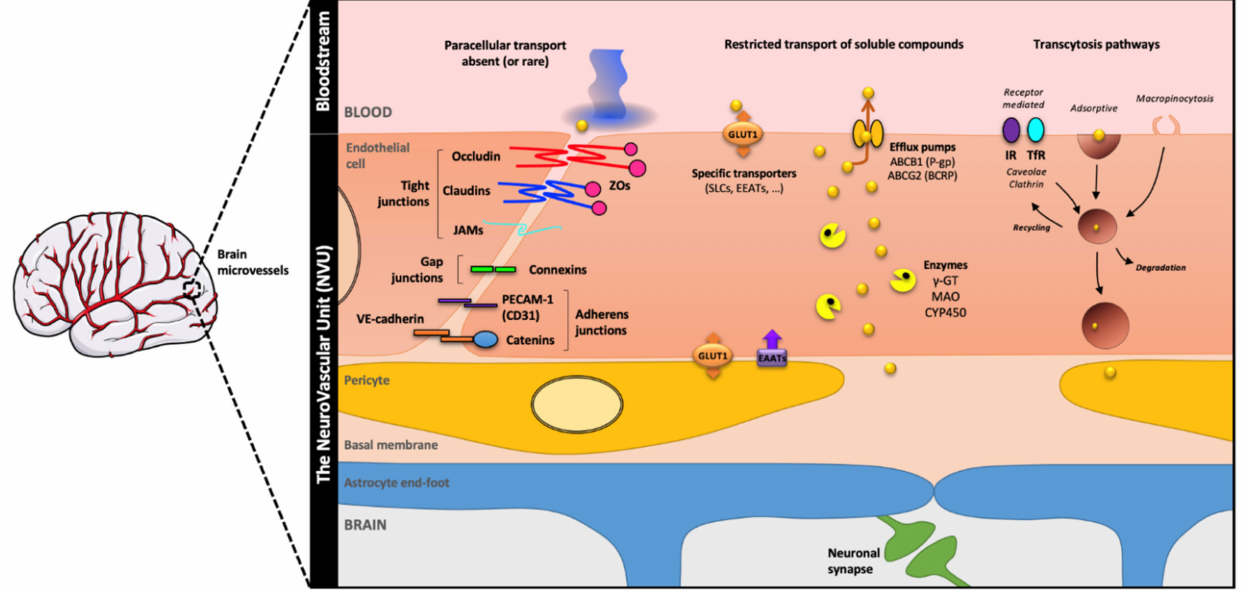
Figure 2. A current overview of the BBB main features . The brain microvessel endothelial cells (ECs) form the BBB that separates the brain and the blood and restricts the exchange between both compartments in order to preserve brain homeostasis. The BBB phenotype, which exhibits two main features referred to as physical and metabolic barriers, is the product of cell–cell communications between ECs and (i) brain pericytes, (ii) astrocytes via their pedicellar extensions, and (iii) progenitor and mature neurons. The physical barrier is defined as such due to (i) the presence of multiple junctional complexes such as TJs which connect ECs, composed of a specific protein complex including claudins, occludin, tricellulin, and zonula occludens (ZOs) proteins, and (ii) reduced transcytosis processes mainly led by adsorptive and receptor-mediated pathways. The metabolic barrier is linked to (i) the limitation of the free diffusion of small soluble compounds by the expression of degradative enzymes by ECs such as monoamine oxidase (MAO) or insulin-degrading enzyme (IDE), and (ii) the presence of efflux pumps belonging to the ABC transporters family which return undesirable molecules into the bloodstream such as xenobiotics. Abbreviation: ABC : ATP